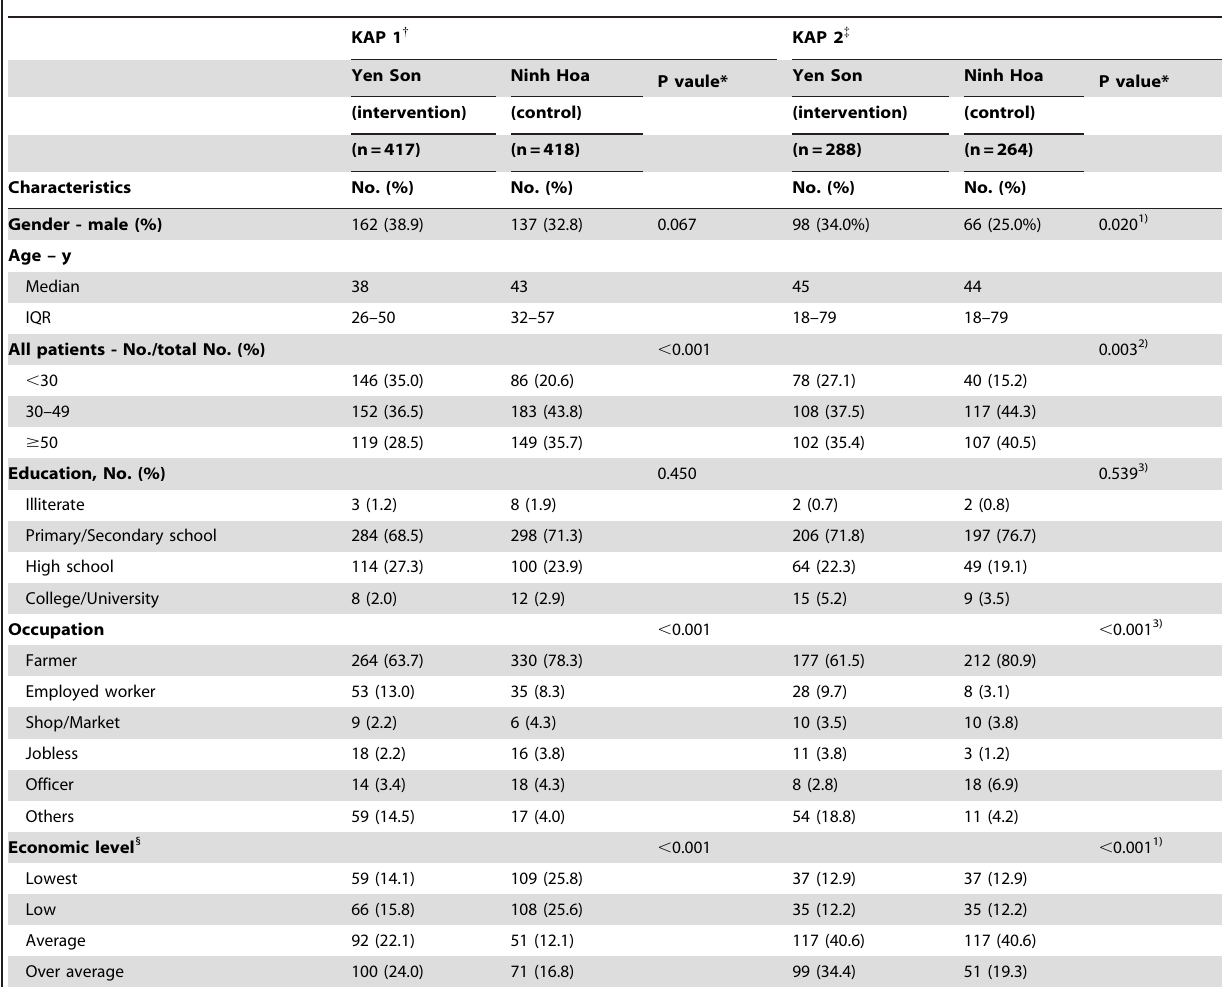
Table 1. Background of study